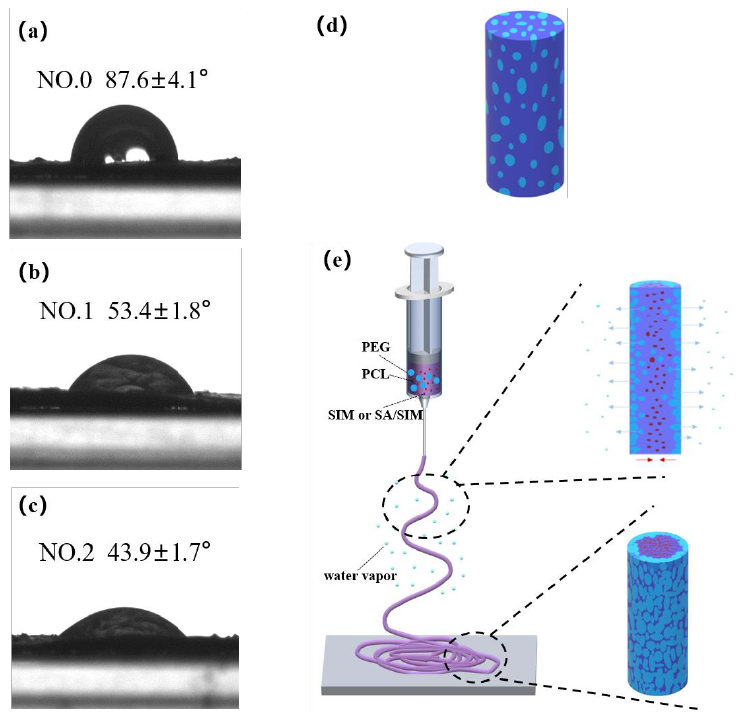
Figure 6. Contact angle test pictures of NFMs (NO.0 ( a ), NO.1 ( b ), NO.2 ( c )), single fiber diagram of NO.0 ( d ) and schematic diagram of material migration during electrospinning ( e ).